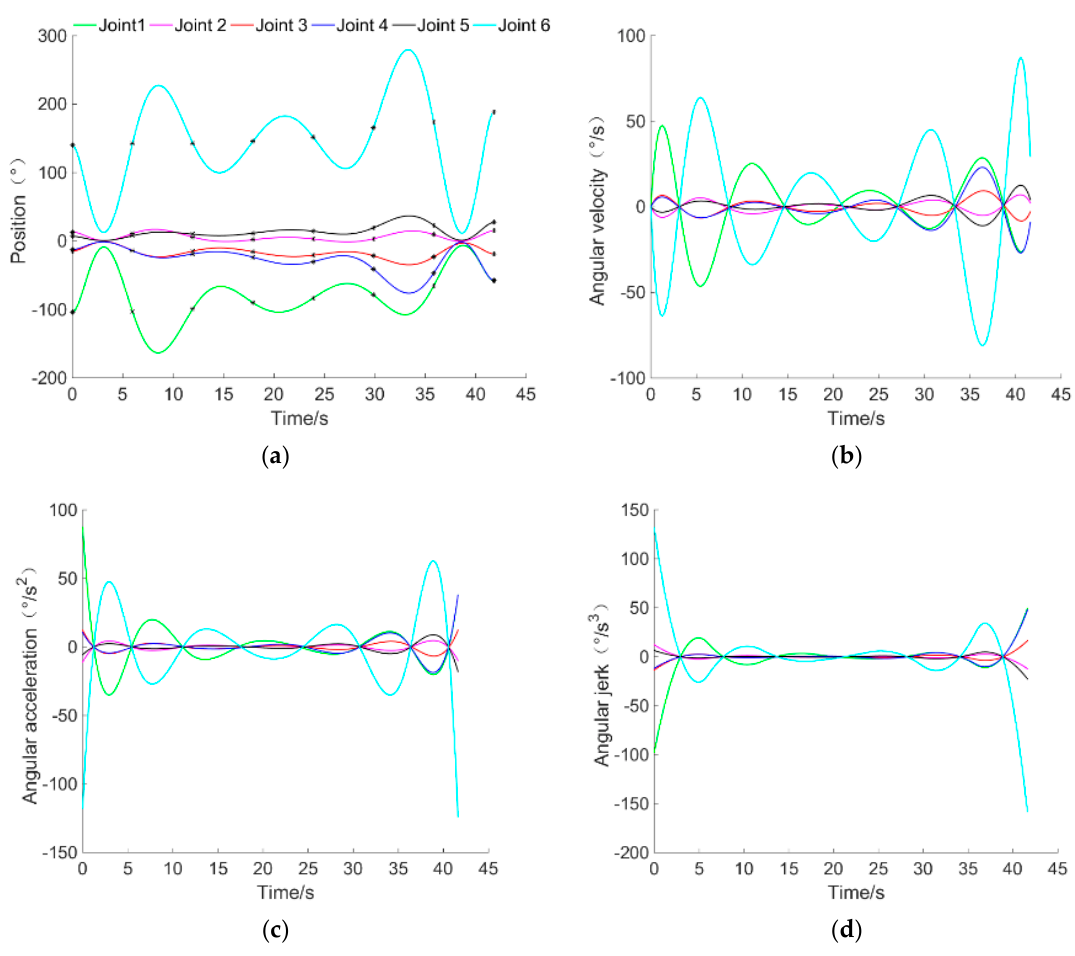
Figure 9. Pulsation optimal trajectory; ( a ) Position − Time chart of each joint; ( b ) Speed − Time chart of each joint speed; ( c ) Acceleration − time chart of each joint; ( d ) Jerk − time chart of each joint.